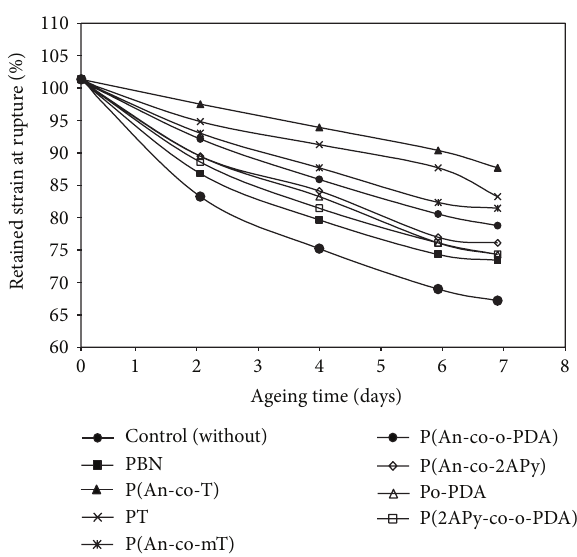
Figure 2: Retained stress at rupture versus ageing time for NR